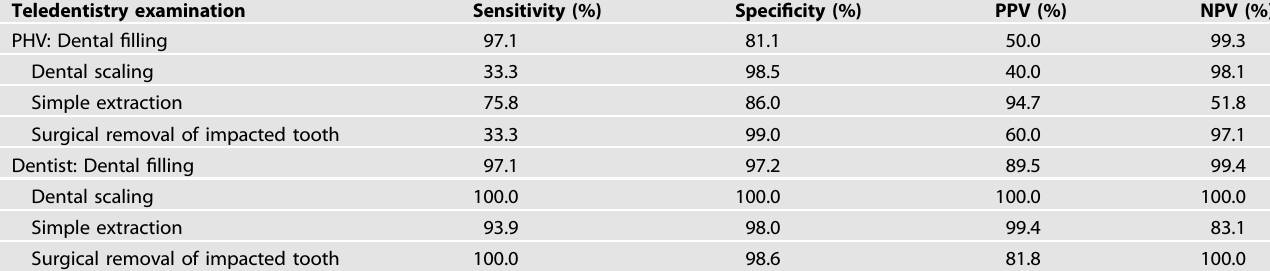
Table 3. Diagnostic accuracy testing between the teledentistry and direct oral examinations. Teledentistry